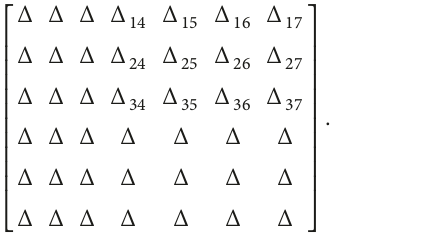
represents the number of wells. “c1” represents acoustic time, “c2” represents caliper, “c3” represents natural gamma, “c4” represents plate radius, “c5” represents induction resistivity, and “c6” represents flushed zone resistivity. “D” is the type of a well, “0” represents dry well, and “1” represents oil well